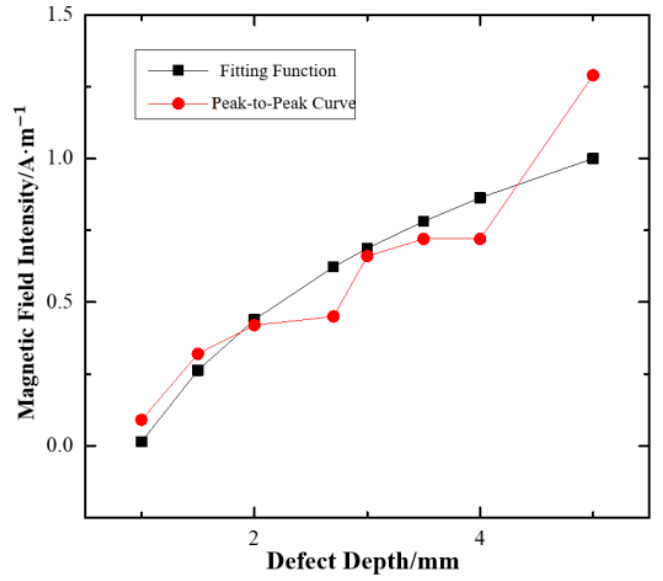
Figure 13. Peak-to-peak values’ function and fitting curve in Bx direction.